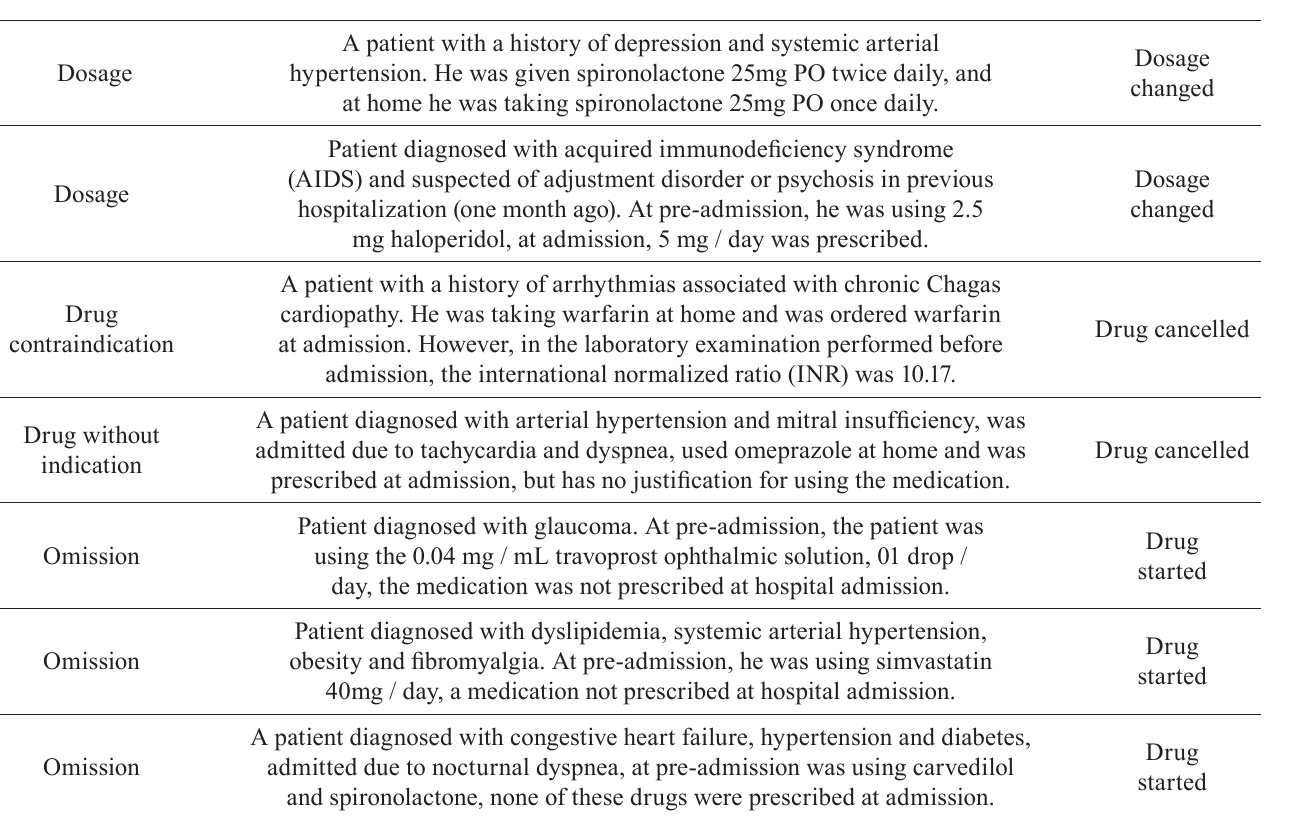
FIGURE I - Examples of unintentional discrepancies and interventions